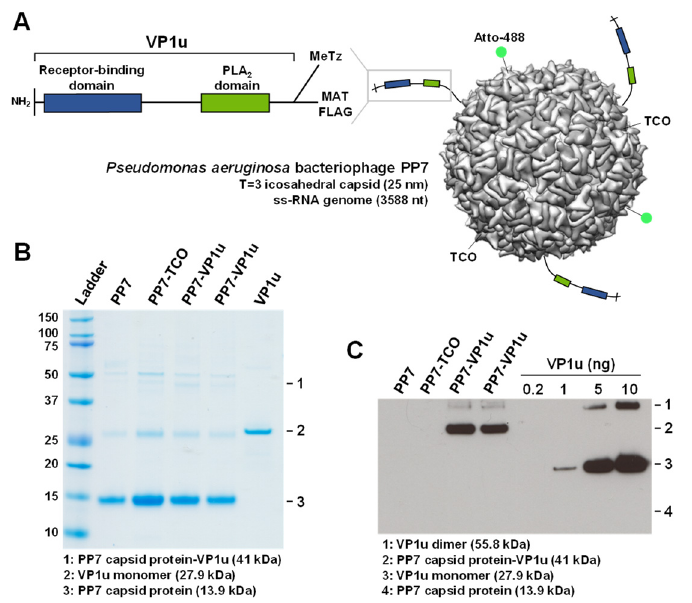
Figure 1. PP7-VP1u bioconjugation. ( A ) Schematic depiction of the PP7-VP1u construct, consisting of a bacteriophage PP7 capsid and three VP1u units of B19V. VP1u contains a C-terminal MAT tag for purification, a C-terminal FLAG tag for detection, and a unique cysteine for crosslinking. Additionally, the capsid was labeled with NHS-Atto488. ( B ) SDS-PAGE and ( C ) Western blot analysis of PP7 capsids, recombinant VP1u, and PP7-VP1u construct (two replicates). VP1u and PP7-VP1u conjugates were detected with an anti-FLAG antibody.